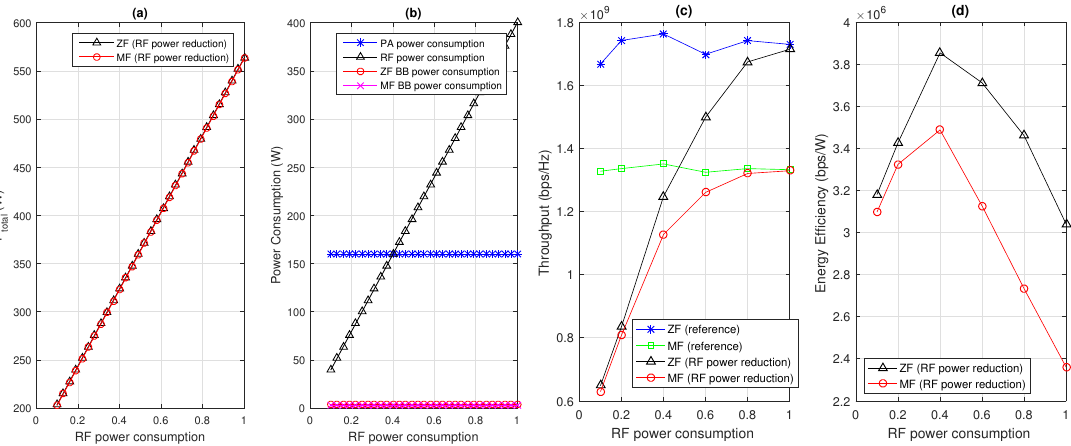
Figure 11. ( a ) total power consumption; and ( b ) power consumption of each component based on RF power consumption, when N t = 400 and K = 40, (cid:36) = 50 Gflop/W, and P PA = 160 W; ( c ) TP (bps); and ( d ) EE (bps/W) based on RF power consumption, when N t = 400 and K = 40, (cid:36) = 50 Gflop/W and P PA = 160